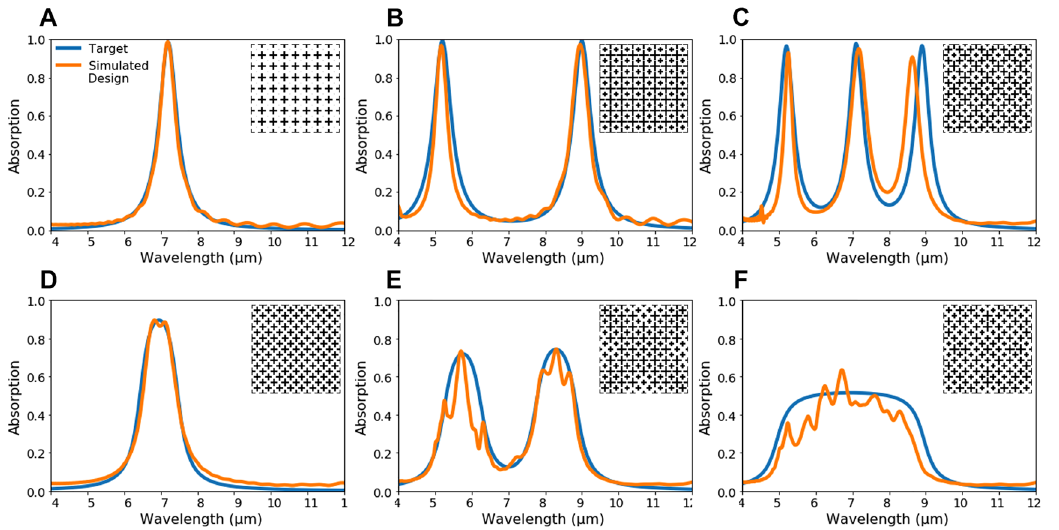
Figure 3: Inverse design of new supercell metasurfaces with the tandem residual network. The structures exhibit (A) narrowband, (B) dual-narrowband, (C) triple-narrowband, (D) broadband, (E) dual-broadband, and (F) graybody behaviors.Blue linesindicate the target spectra used as inputs to the network, andorange lines representthe simulated results of the output design parameters. Inset images show the physical layouts of the network-generated